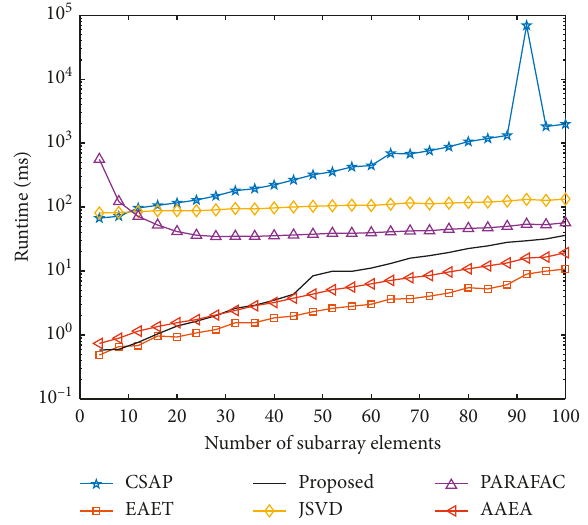
Figure 6: Runtime vs. the number of subarray elements with K 3, J 500, and SNR (cid:28) (cid:28)